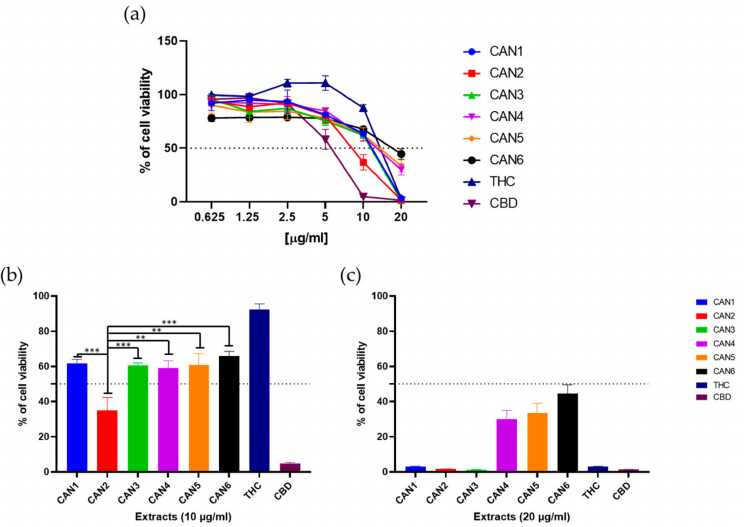
Figure 4. Responsiveness of the Caco-2 cell line to different Cannabis sativa extracts, THC, and CBD. ( a ) Cells were treated with different concentrations (0.625–20 µ g/mL) of the extracts for 48 h, and the MTT assay determined cell viability. Sections ( b , c ) show the concentrations of 10 µ g/mL and 20 µ g/mL, respectively. Data show cell viability relative to untreated controls (mean ± S.D. from n = 4 repeated measurements). Statistical significance is defined as ** p < 0.005 and *** p < 0.0005 (ANOVA test) for all sample